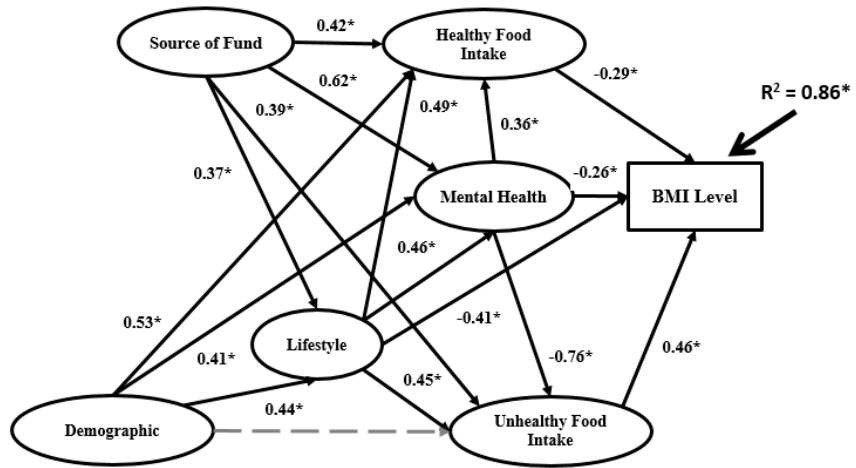
Figure 7. Final BSEM outputs of the PhD model.